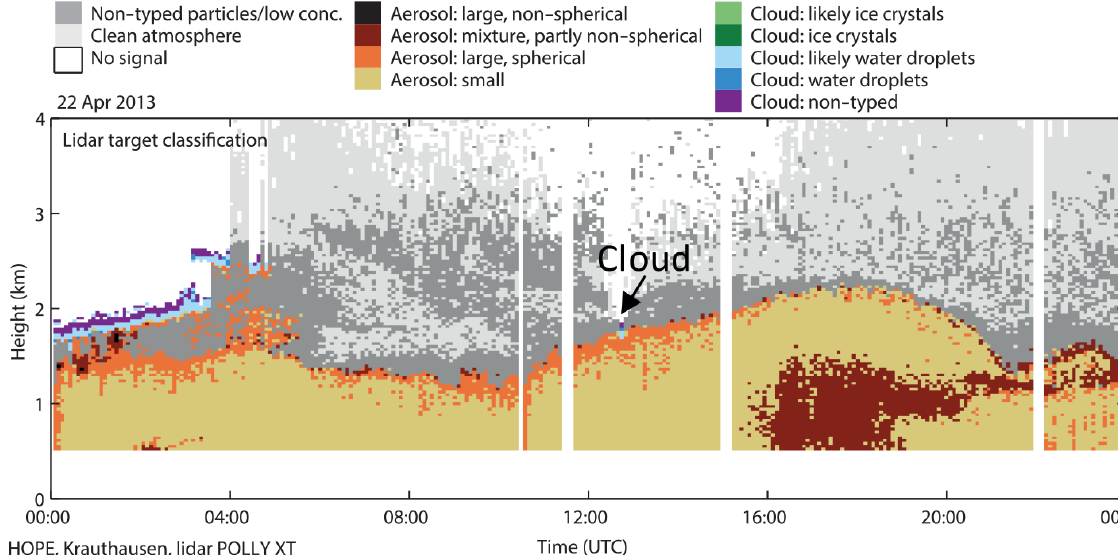
Figure 8. Lidar particle categorization for 22 April 2013.